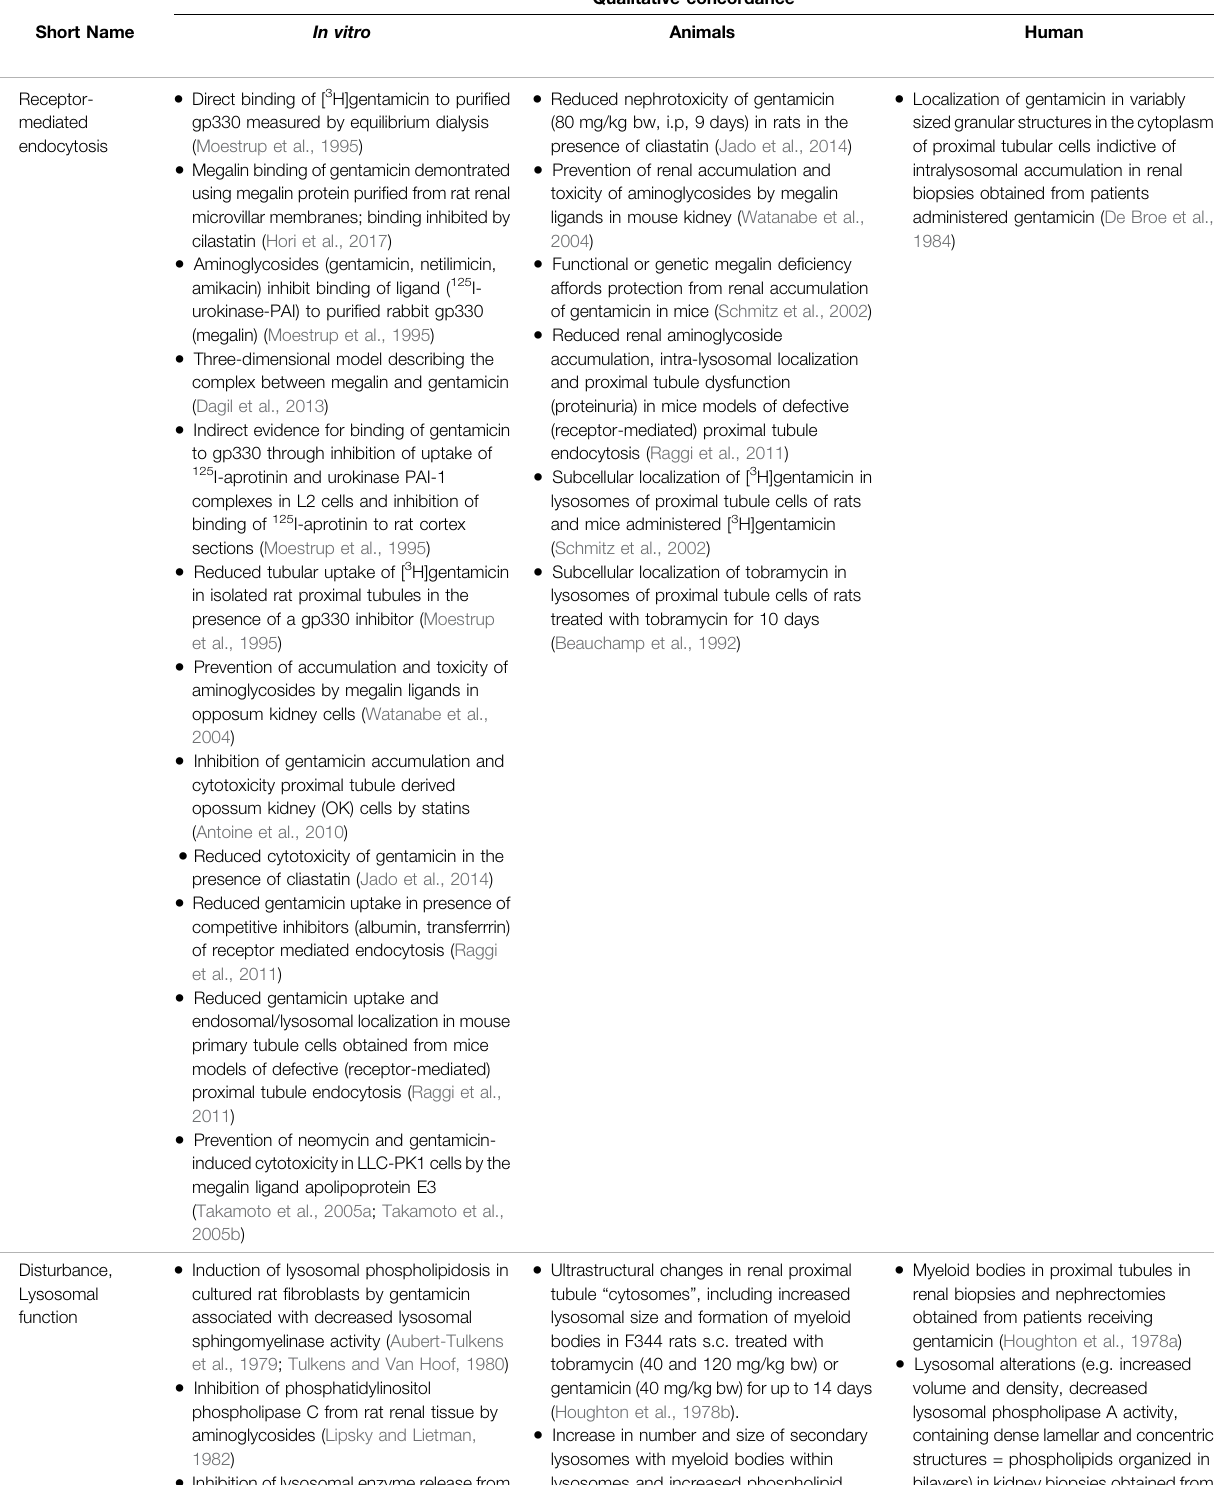
TABLE4A| Evidencefromhuman,animaland invitro studieson aminoglycosides supportingthekeyeventsandqualitativeconcordanceofKEswithinthisAOP(n/a=not data available).